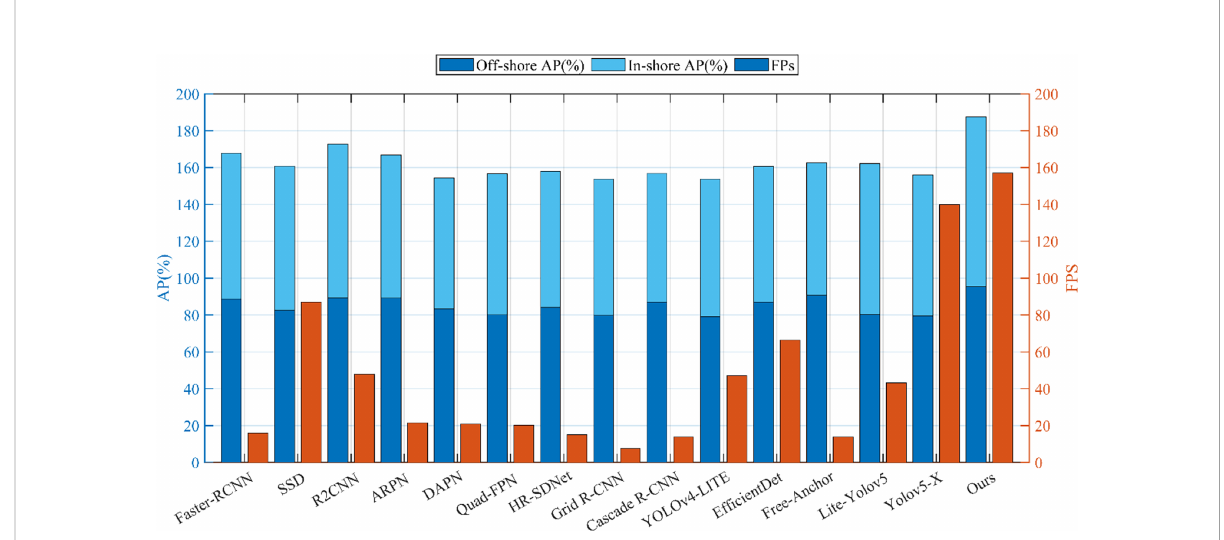
FIGURE 9 Performances of AP and FPS for various CNN-based techniques on offshore and inshore ships for SSDD